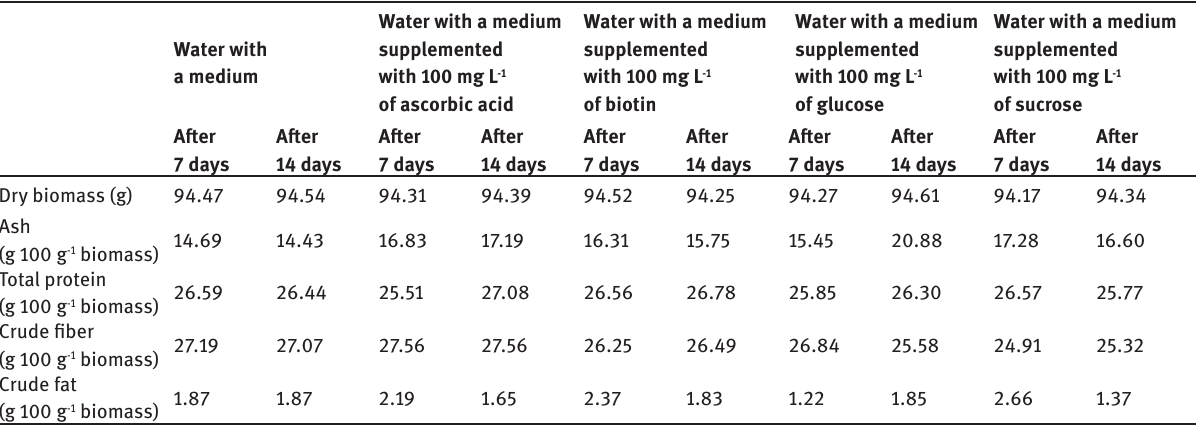
Table 1: Analysis of Aegagropila linnaei biomass cultured in the laboratory in water with a nutrient medium supplemented with bioactive organic compounds